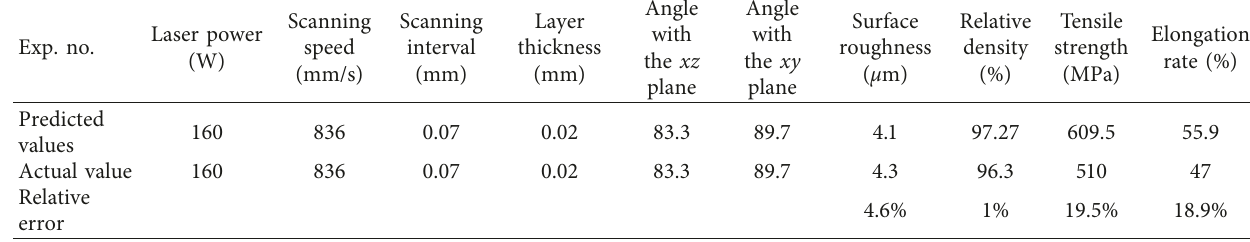
Table 8: Predicted and actual results under optimized